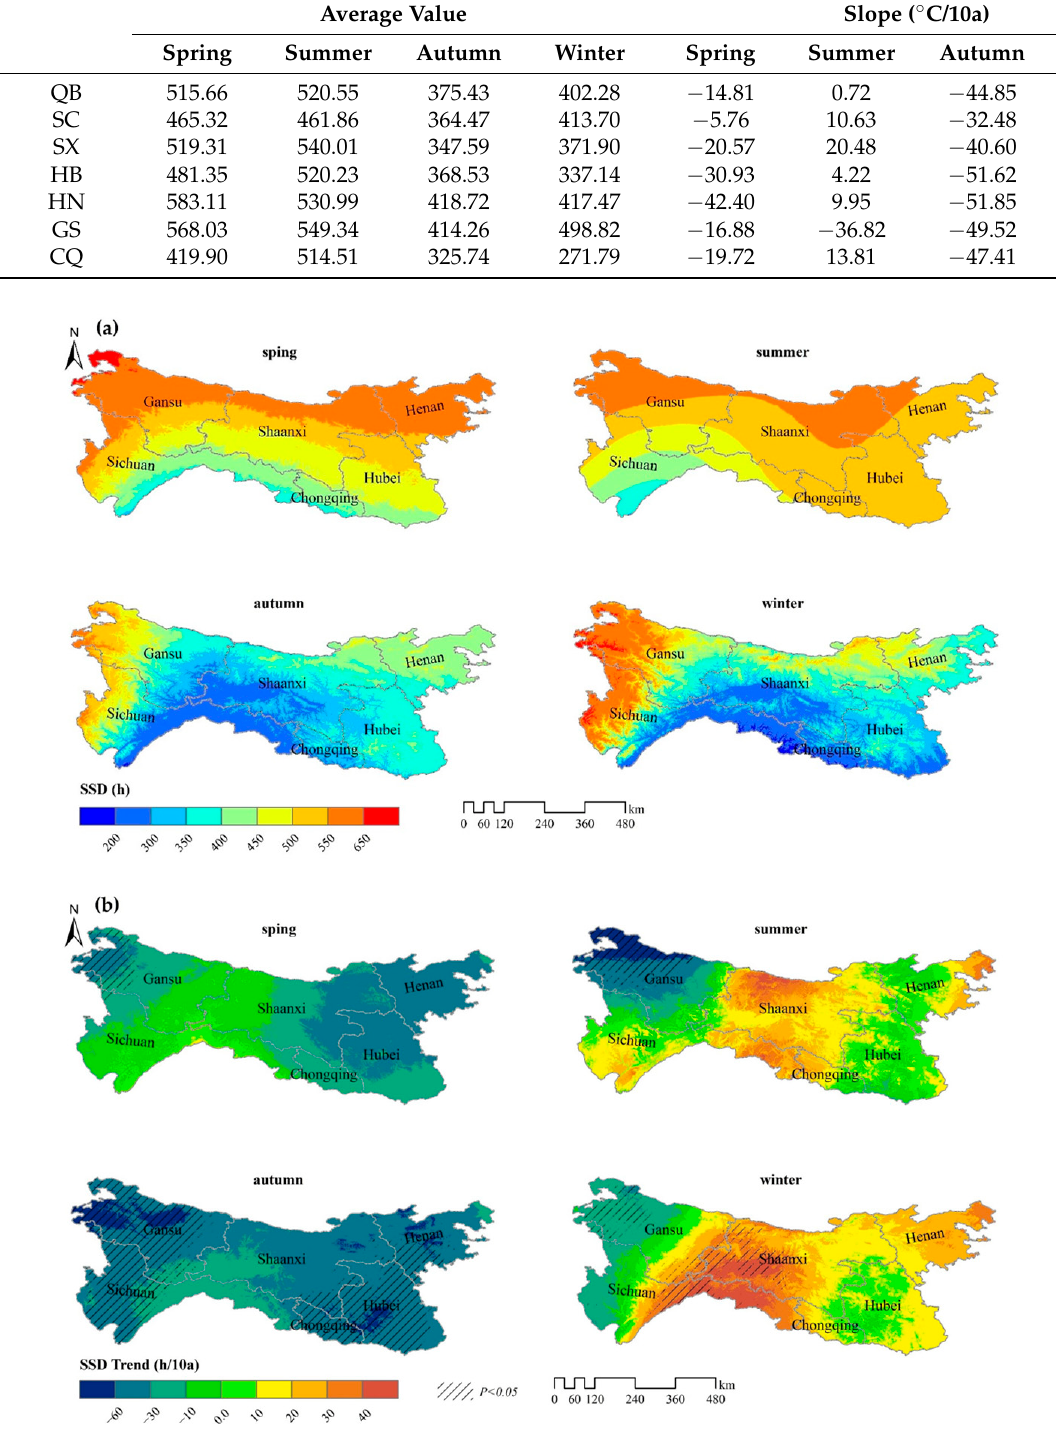
Table 8. Seasonal average and change trend rate of SSD in the QBM.